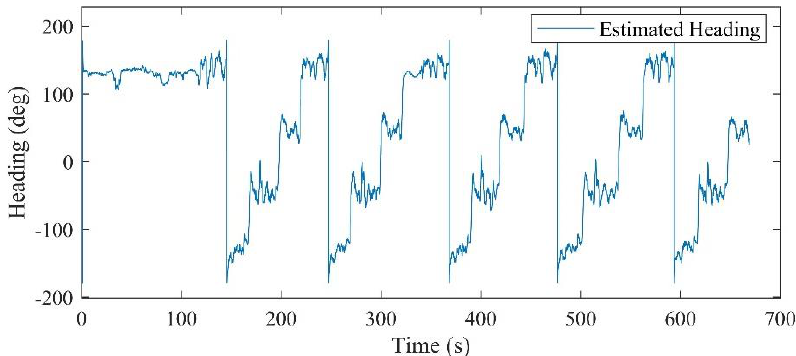
Sensors 2021 , 21 , 3615 Figure 15. ( a ): The estimated roll for the second scenario, ( b ): the estimated pitch for the second scenario.